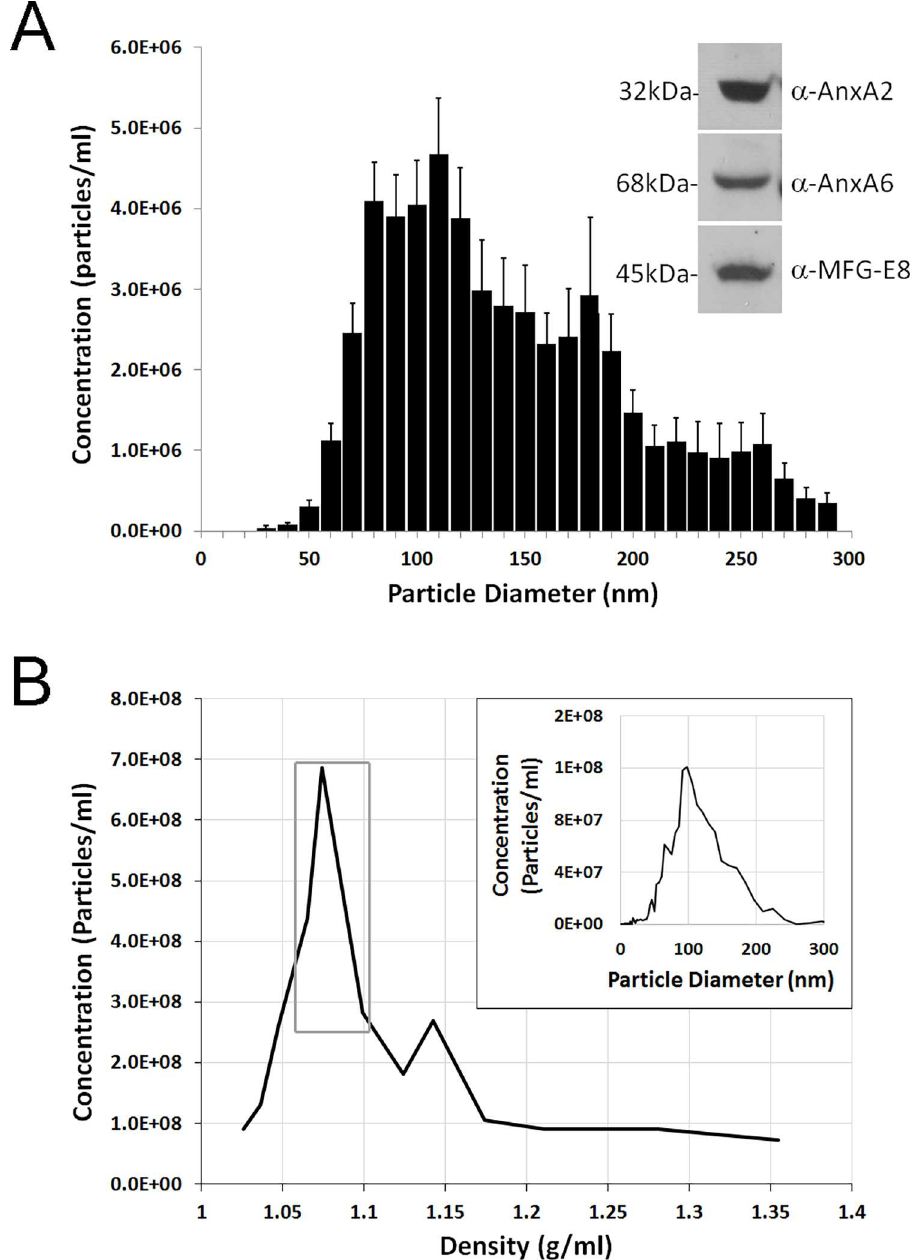
Fig 1. Human trabecular meshwork (TM) explants releaseexosomes. (A) TM explantsfrom six human donoreyes wereculturedseparatelyfor 72 hours. Extracellular vesicles(EVs) were preparedfrom the conditioned mediaand analyzedfor size by nanoparticletracking analysis(NTA) and proteincontent by westernblot (inset). NTA data is binnedin 10 nm incrementsand representthe mean ± SDof six individual biologicalreplicates.Western blots are representative of the results obtainedfrom the six individual biological replicates. AnxA2, Annexin2; AnxA6, Annexin6; MFG-E8, lactadherin. (B) A single humanTM explantwas culturedfor 9 days (media collectedevery 3 days). This mediawas concentrated by ultrafiltration and mixed into the bottom portionof an Iodixanol(OptiPrep) densitygradientandultracentrifugedovernight.Fractions werecollected,their densitywas determined and the concentration of EVs in each fraction was determined by NTA. Fractions correspondingto the densityof exosomes (1.07–1.10g/ml, gray box) werecombinedand analyzedfor size distribution by NTA